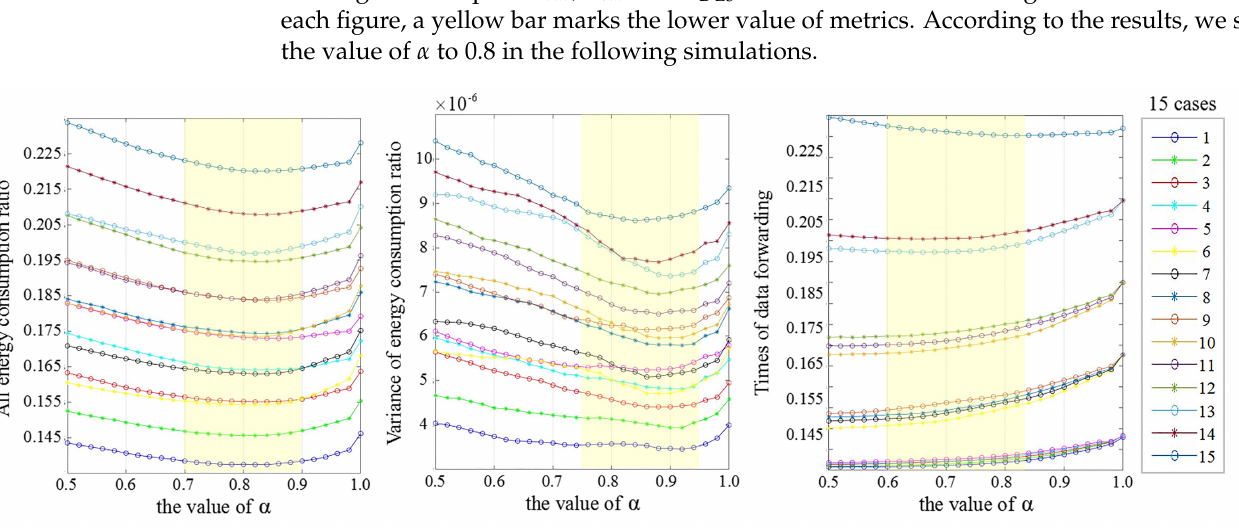
Figure 14. Under 15 cases, the results of E rat , E var and T DL 3 are shown in this figure when α changes from 0.5 to 1.0. The yellow bar marks the lower value of